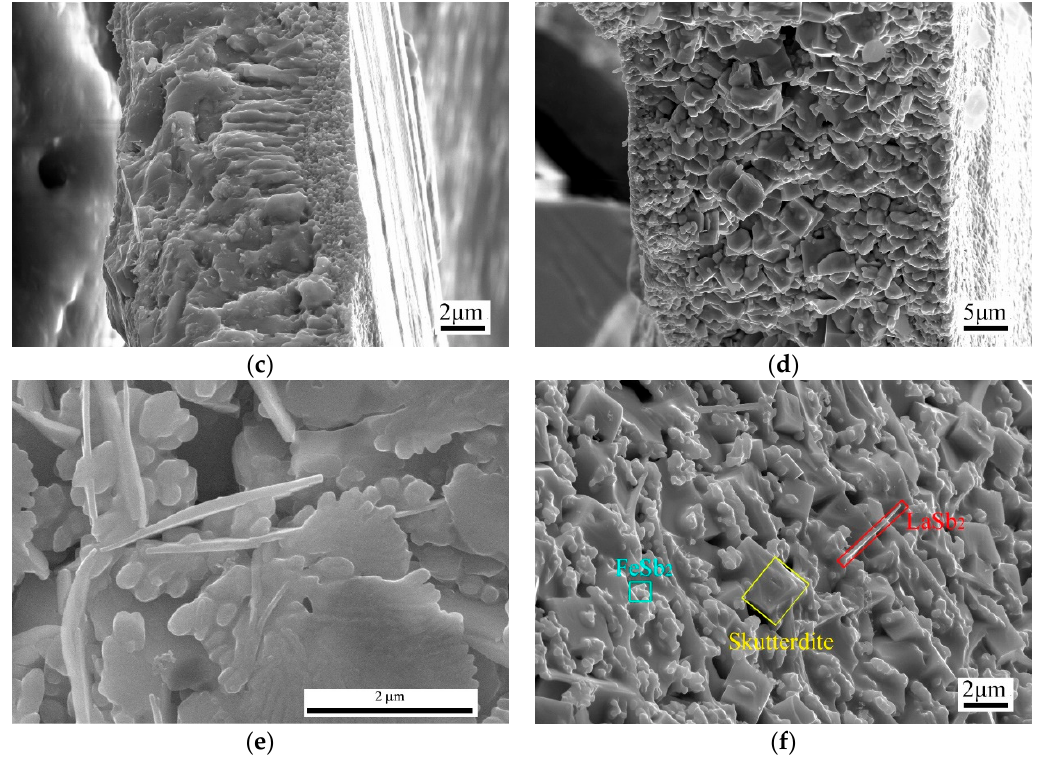
Figure 3. ( a ) The cross-section of various spun ribbons. ( b ) The microstructure of the ribbon with a thickness of 8 µm, nanograins existed near the wheel side. ( c ) The microstructure of the ribbon with a thickness of 13 µm, a columnar crystal layer existed in the center of the ribbon. ( d ) The microstructure of the ribbon with a thickness of 43 µm, the grain size was uniform across the thickness. ( e ) The free side of the 13 µm spun ribbon. The skutterudite dendrites lay parallel to the wheel side. ( f ) The free side of the 43 µm spun ribbon. The volume fraction of LaSb 2 and (Fe,Co)Sb 2 phases increased because of the lower cooling rate.